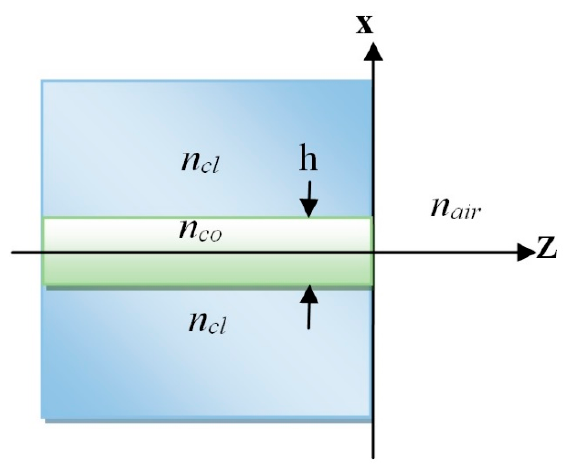
Figure 1. Schematic diagram of a 2-dimensional waveguide facet terminated by air.